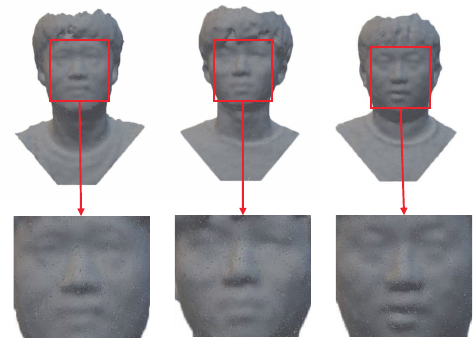
Figure 9. Geometric shape detail of facial reconstruction. We can see that we have clearly recovered the geometric shape of facial features even for small differences in